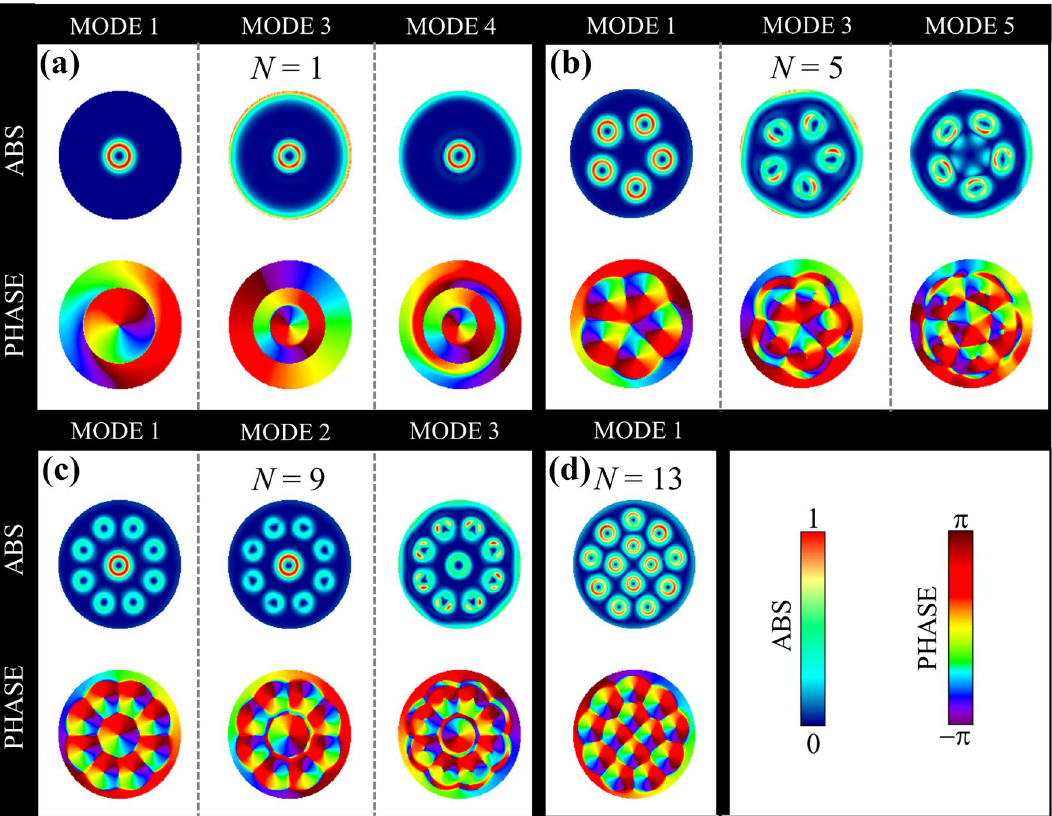
Figure 4. z -component and spectral phase of the spatial distribution of the dynamic susceptibility for each resonance frequency of the skyrmion cluster when a magnetic pulse was applied along the x -axis for the cases ( a ) N = 1 , ( b ) N = 5 , ( c ) N = 9 , and ( d ) N = 13 . In the upper row the bright part (red) reflects high spin precession amplitude and the dark part (blue) corresponds to zero amplitude, while the bottom row represents the phase at which the spins